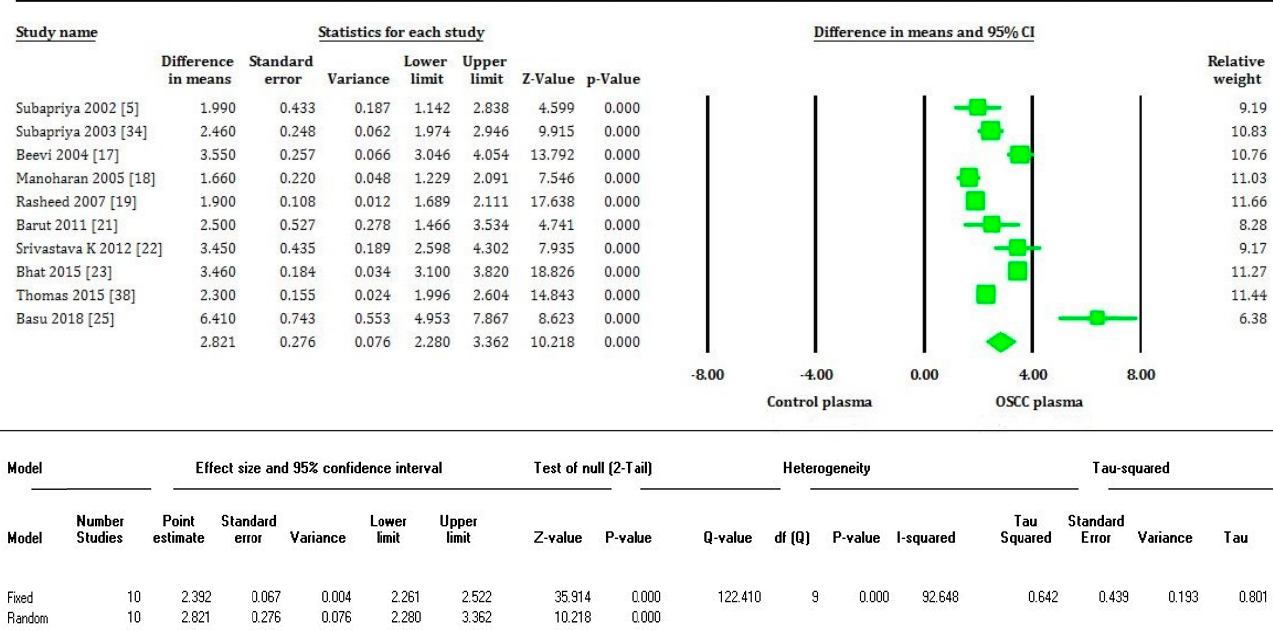
Figure 3. Forest plot shows mean difference estimates with 95% confidence intervals representing differences in serum levels of MDA between oral squamous cell carcinoma group and healthy controls.